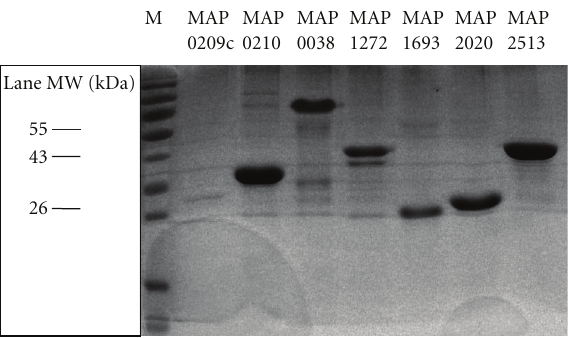
Figure 1: Recombinant proteins analyzed by coomassie-stained SDS-PAGE to test